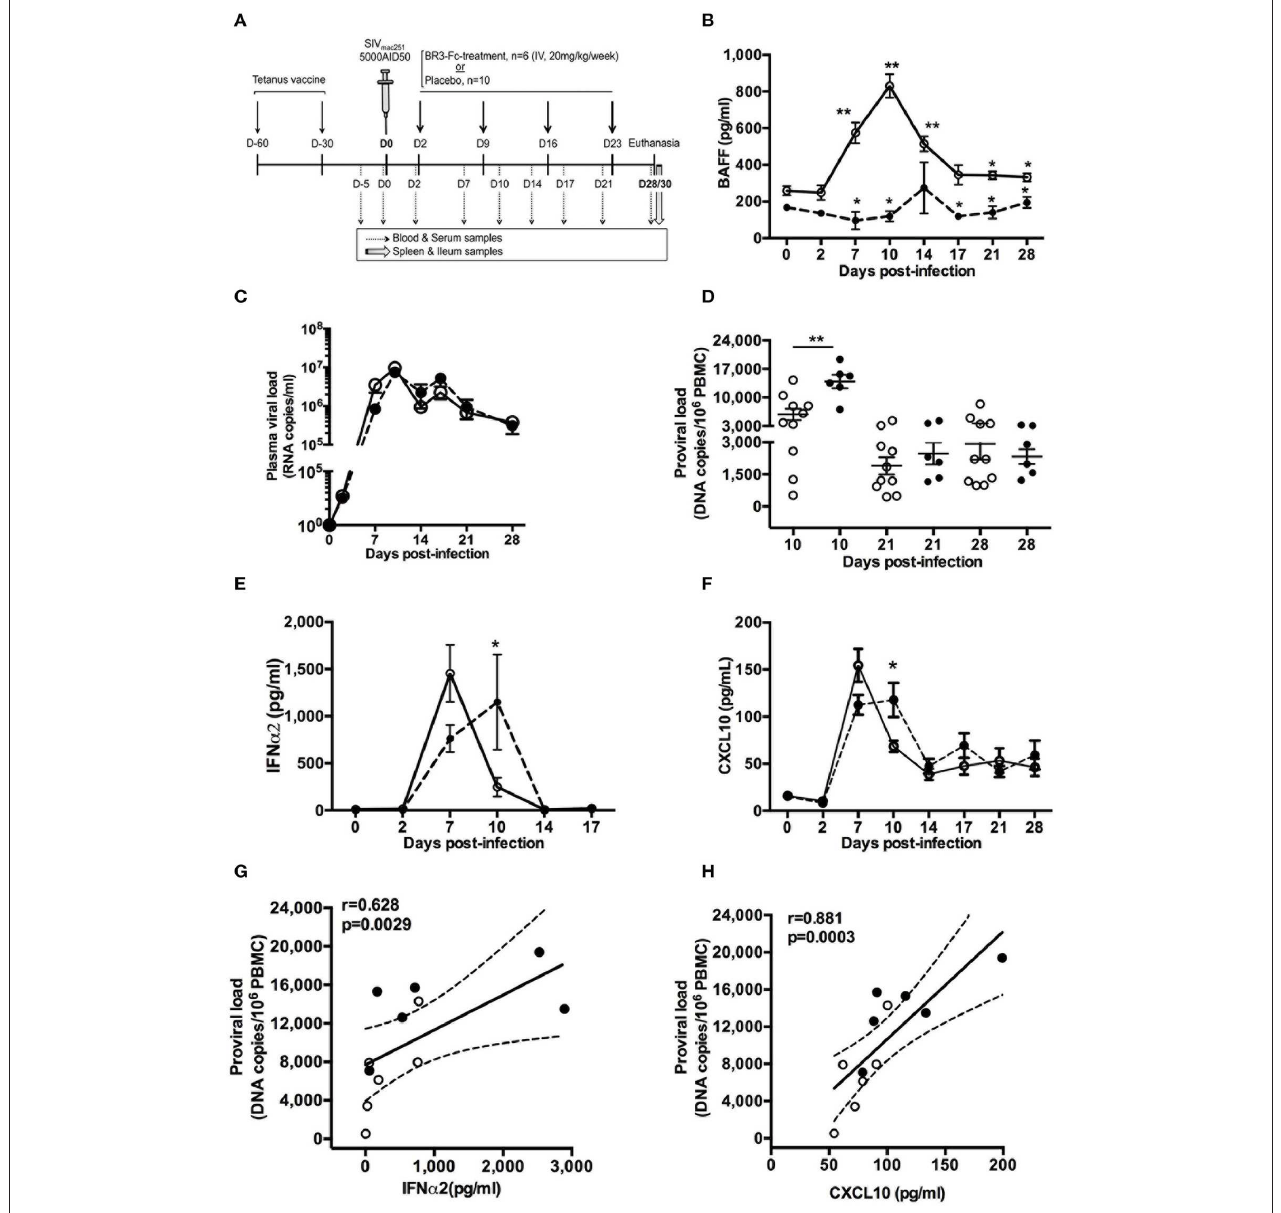
FIGURE 1 | BR3-Fc treatment impairs kinetics of inflammatory cytokine production but not that of plasma viral load. (A) All macaques were vaccinated with Tetanus Toxoid (TT) vaccine 60 and 30 days before infection and then intravenously infected with 5000 AID50 SIV mac251 . Six macaques were treated by soluble BR3-Fc (20 mg/kg/week) for 4 weeks ( BR3-Fc treated group ). Ten vehicle-treated or untreated SIV-infected macaques constituted the Placebo group. Blood and serum were collected before infection, every 3 dpi (dotted arrows) and at euthanasia. Spleen and terminal ileum were taken at necropsy from all macaques (gray arrow). (B) Plasma BAFF levels were quantified by ELISA prior to infection (baseline value, D0) and at different time points after infection. Symbols represent the Mean ± SEM value for Placebo ( open circle, plain line ) or Treated ( black circle; dotted line ) groups. For Placebo, statistical comparison between values at D0 and at every time point post-infection was carried using the Wilcoxon t -test * p < 0.05, ** p < 0.001 ( asterisks above the plain line ). Statistical comparison between Placebo and Treated groups at each time point was carried out using the Mann Whitney non-parametric test * p < 0.05, ** p < 0.001 ( asterisks above the dotted line ). (C) Plasma viral loads were measured at different time points for both groups. No statistical difference between groups was observed. (D) Pro-viral loads in PBMC were quantified at 10, 21, and 28 dpi. Statistics were carried out using the Mann Whitney non-parametric test, ** p < 0.001. (E,F) ELISA was used to quantify plasma levels of IFN α 2 (E) and CXCL10 (F) prior to infection and every 3 dpi for both groups. Statistical comparison between groups at every time point was carried out using the Mann Whitney non-parametric test, * p < 0.05. For (B,C,E,F) symbols represent the Mean ( ± SEM) value at each time point. For (D) , each dot represents one macaque of either Placebo ( open circle, plain line ) or Treated ( black circle; dotted line ) group. Bars represent Mean values ± SEM. (G,H) Correlations between the pro-viral load and levels of plasma IFN α 2 (G) and CXCL10 (H) at 10 dpi are shown. Each dot on the graphs represents one macaque from Placebo ( open circle ) or Treated ( black circle ) group. Spearman rank test was used for statistical analysis. rho and p -values are